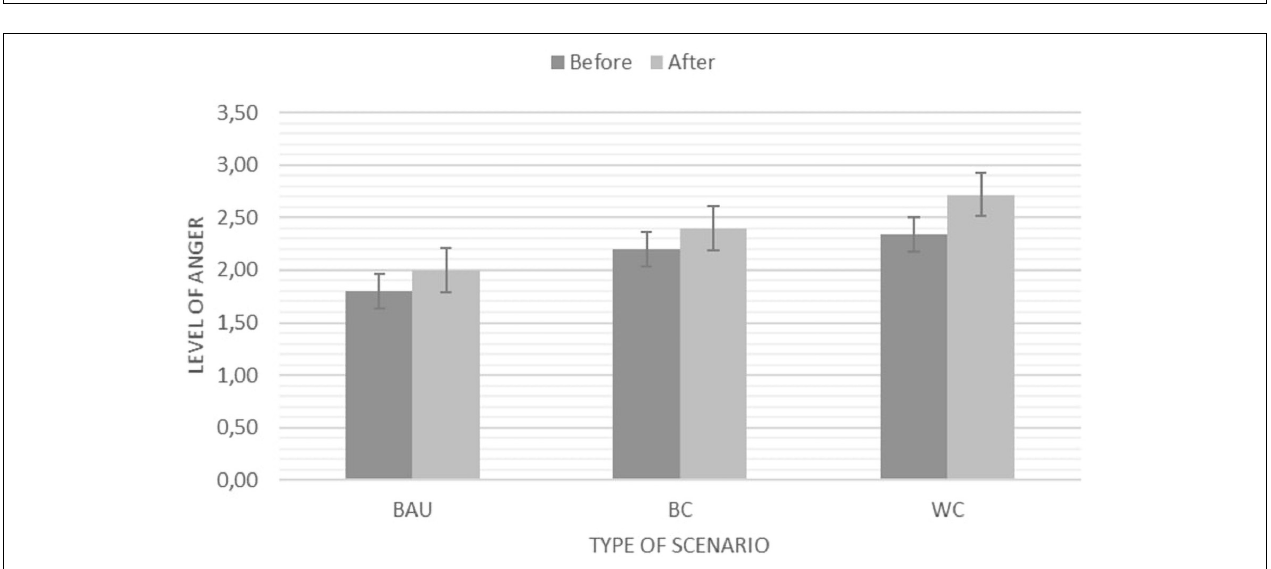
FIGURE 9 | Significant main effect and interaction for the feeling of empowerment before and after engaging with one of the three scenarios (BAU, Business as Usual; BC, Best Case Scenario; and WC, Worst Case Scenario). NB: Y -axis adapted for illustration purposes. The Likert scale ranges from 1 ( Strongly disagree ) – 5 ( Strongly agree ).